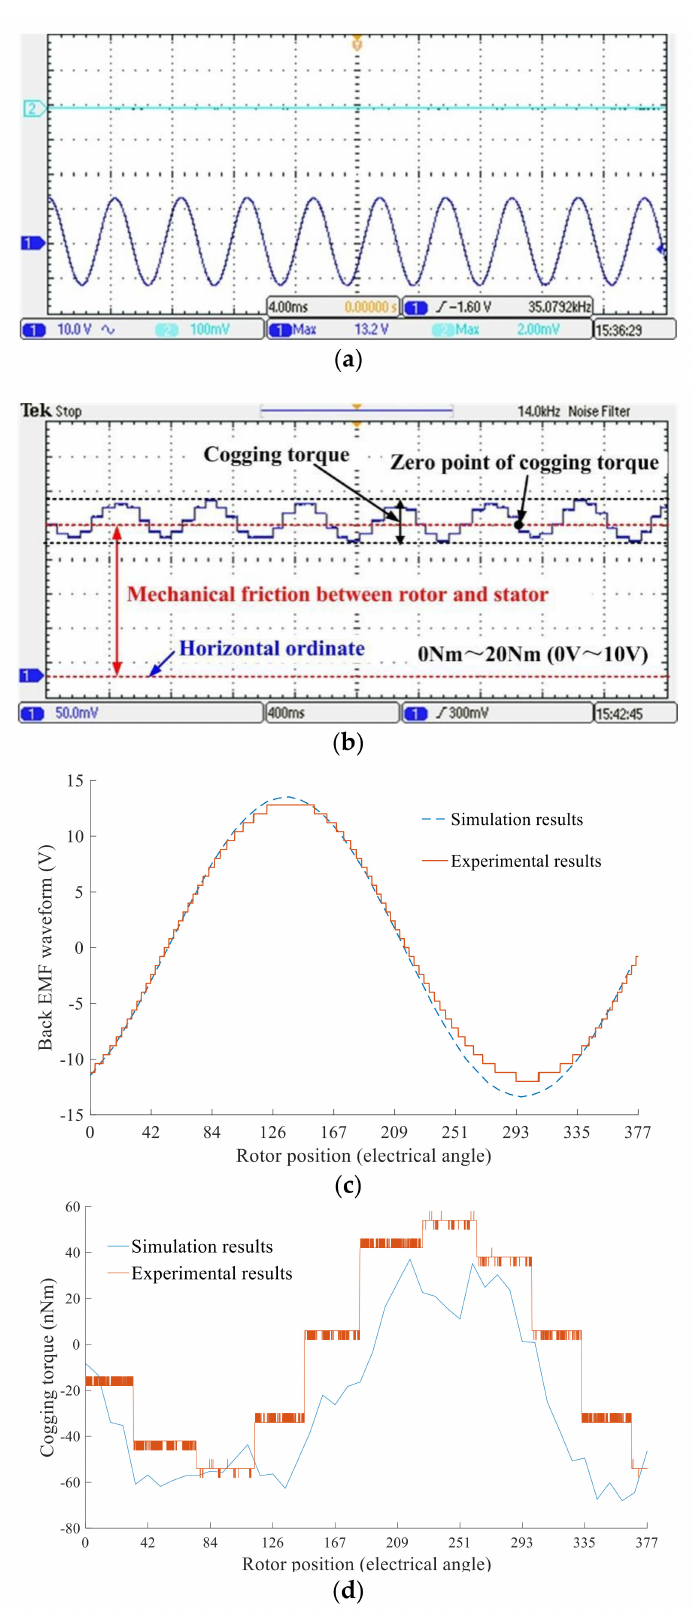
Figure 8. The experimental and comparison results of the VFMPM machine in weakened flux condition. ( a ) Experimental results of back EMF waveforms; ( b ) Experimental results of cogging torque; ( c ) Comparison of back EMF waveforms; ( d ) Comparison of cogging